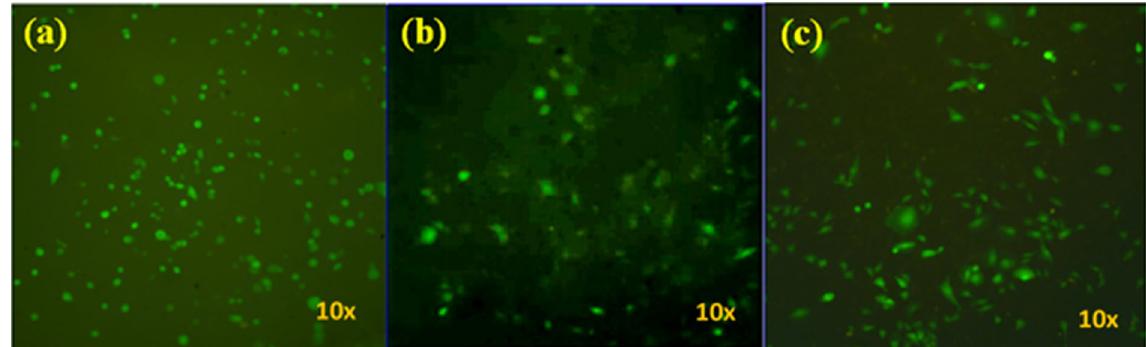
Figure 3. Growth of MDA-MB-231 cells on the surface of ( a ) HA, ( b ) S0, and ( c ) S3.0 nanocomposites.